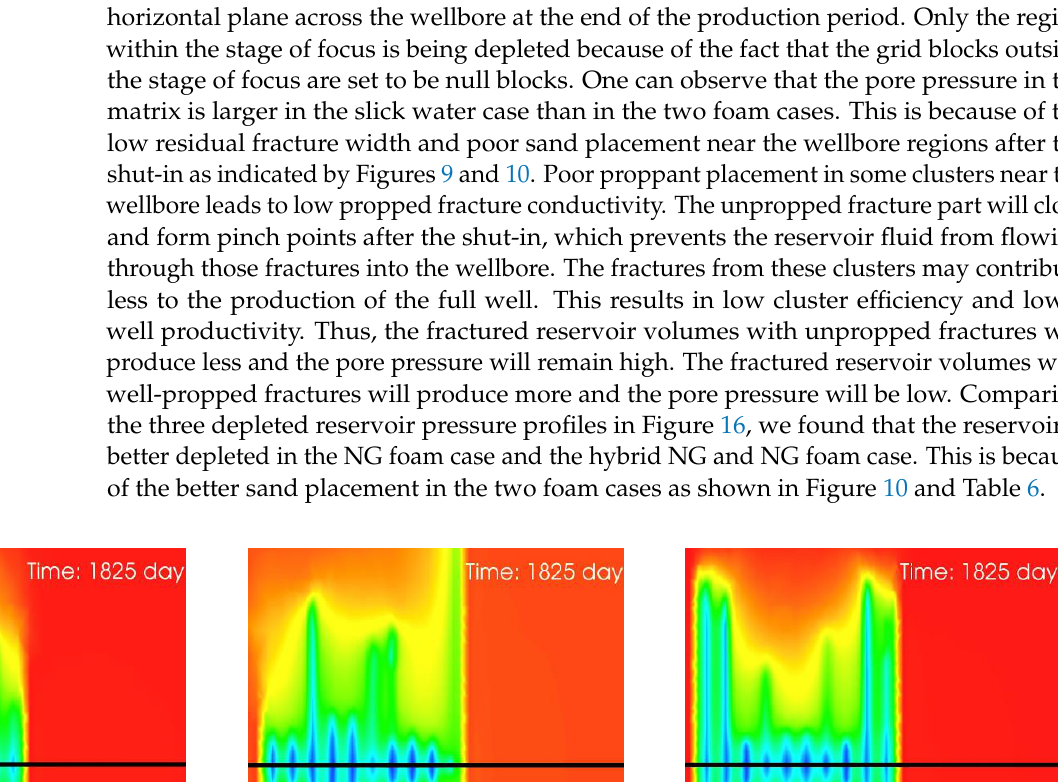
Figure 17. Surface production. ( a ) Cumulative surface oil production, ( b ) Cumulative surface gas production.